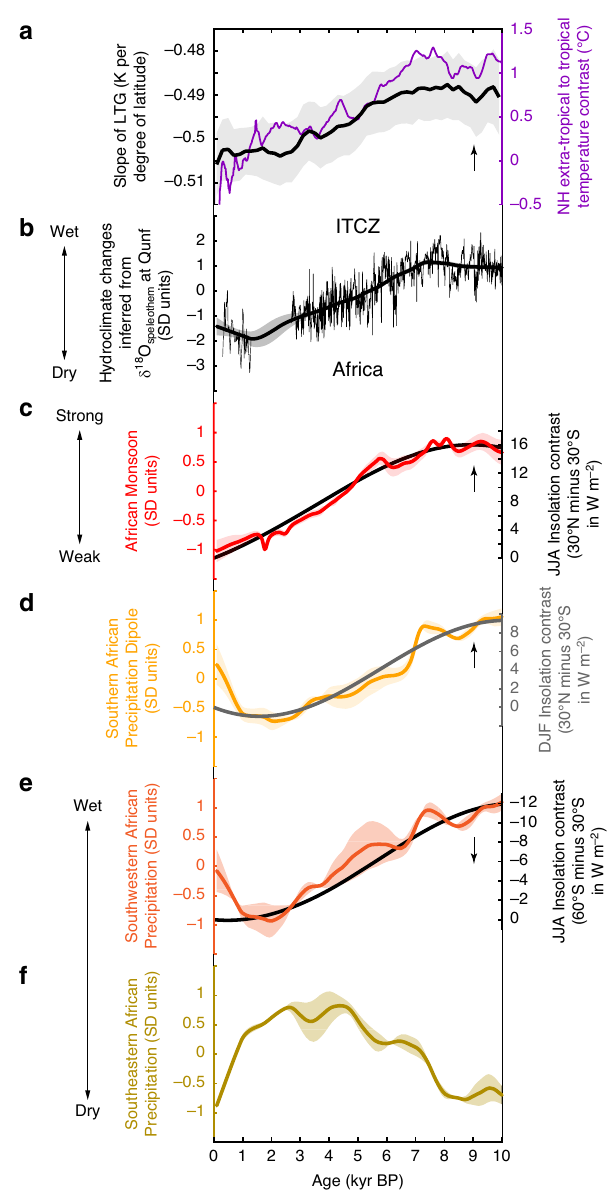
the South American Monsoon, precipitation falls nearly year- round at Paraíso cave 19 (Fig. 2). Thus, we suggest that the observed change in precipitation at Paraíso cave since 10 kyr BP is related to variations in the seasonal distribution of precipita- tion. From 10 to 6 kyr BP, increased precipitation was caused by a